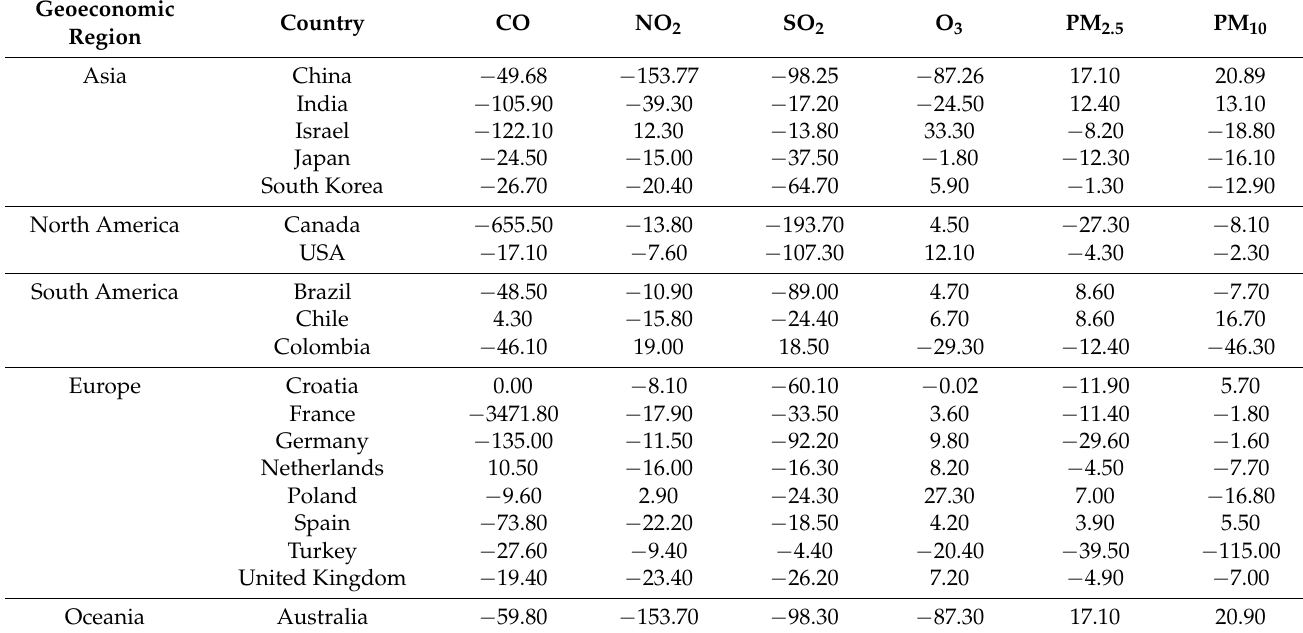
Table 2. Main effects of the containment policy of lockdown to face COVID-19 on average levels of air pollutants between selected countries worldwide. Average Variation % of Air Pollutant Values from January 2019 to March 2022 Compared with Baseline Period